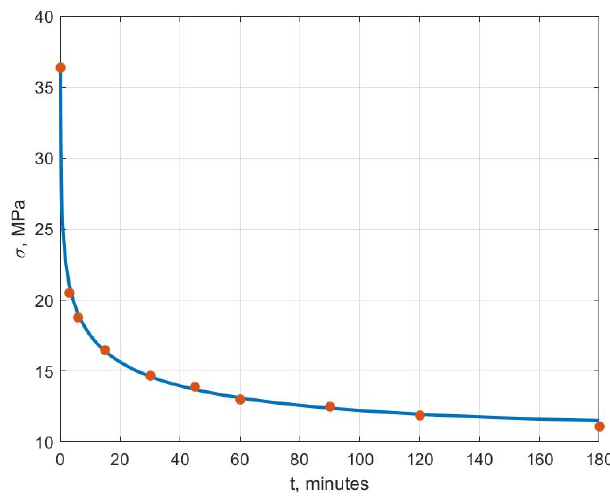
Figure 9. Stress relaxation curve at 𝑇 = 50 °C .